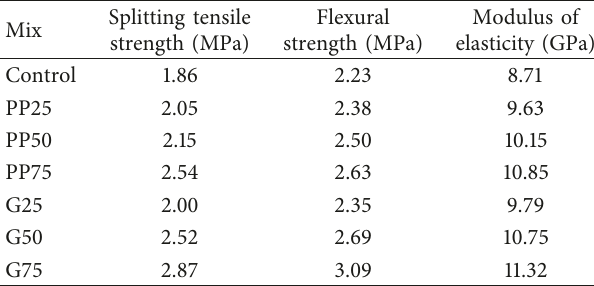
Figure 7: Relationship between 7-day and 28-day compressive strengths. Table 5: Splitting tensile and flexural strengths and modulus of elasticity of concretes (28